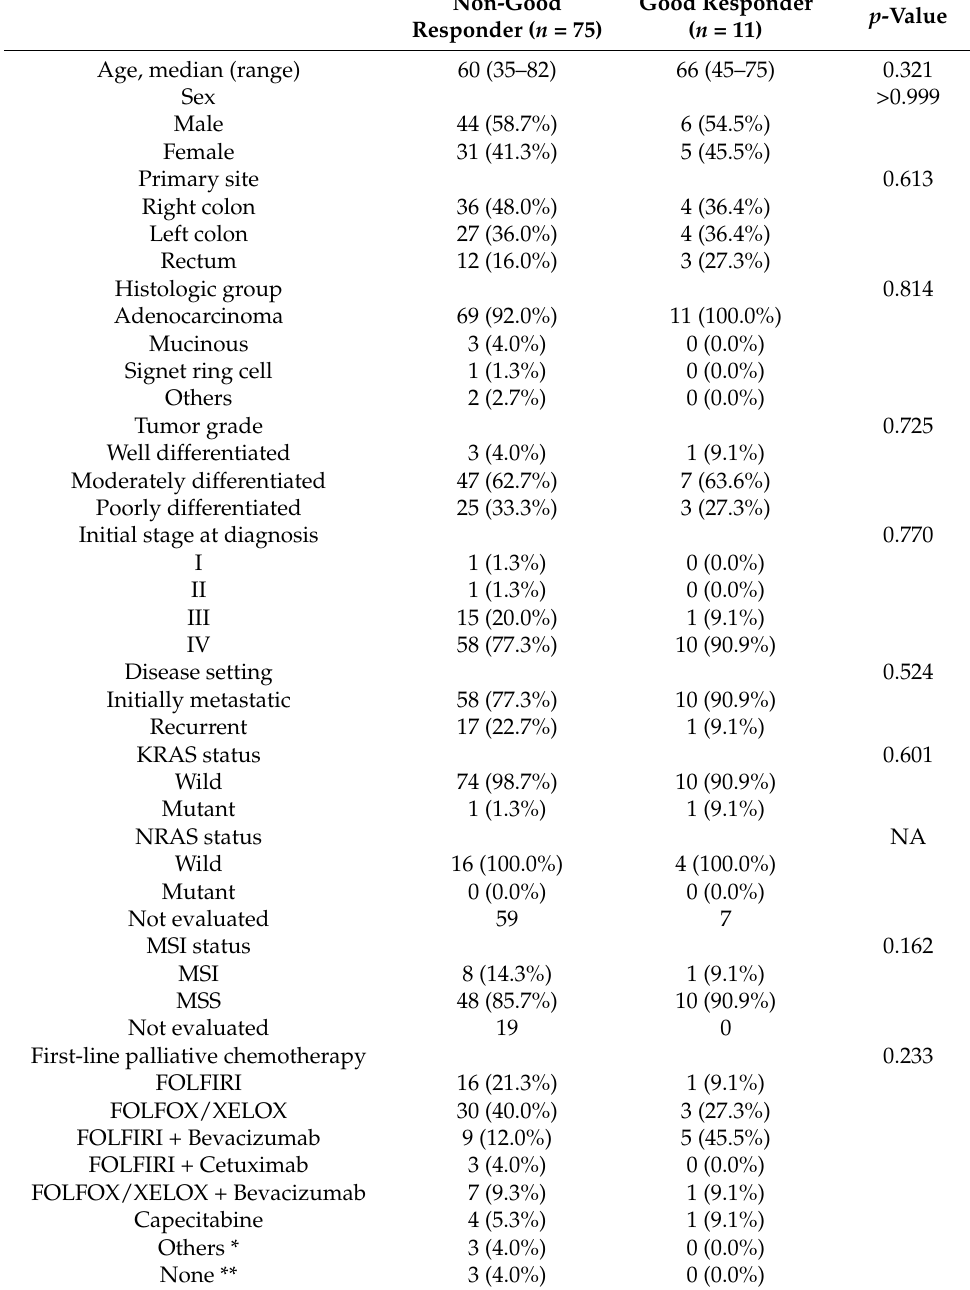
Table 1. Patient characteristics according to treatment response after palliative